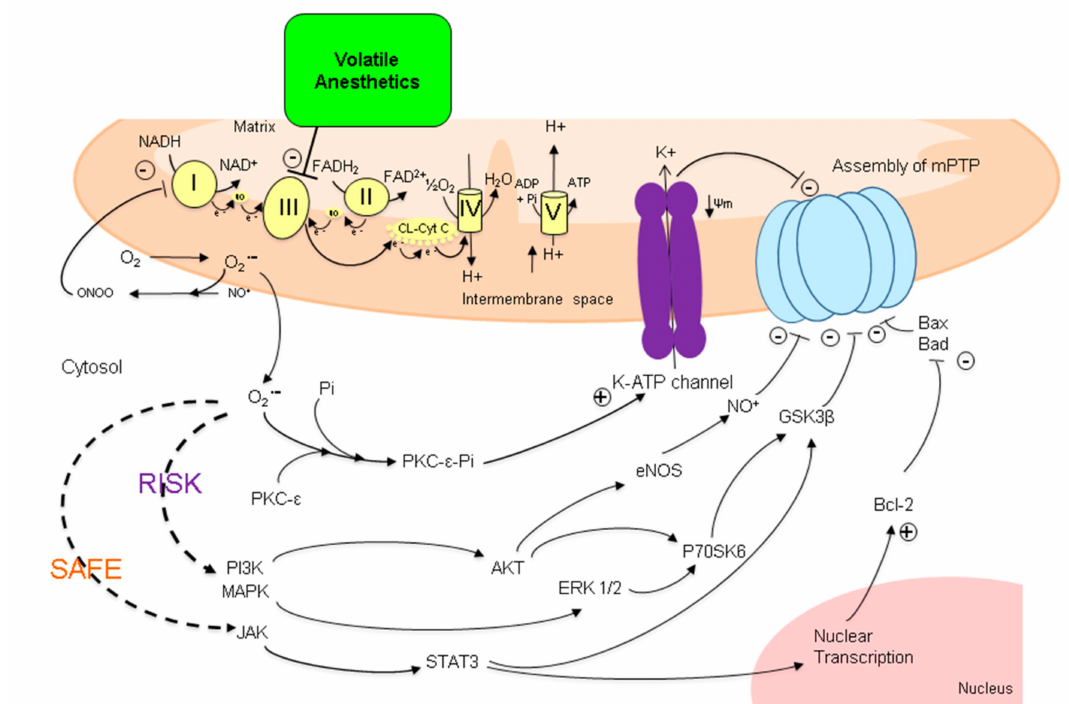
Figure 2. Proposed effects of volatile anesthetics on the level of mitochondria. VA are likely to reduce complex III activity in the mitochondrial respiratory chain, resulting in an increase in superoxide (an ROS) formation. Superoxide then may react with nitric oxide, resulting in the formation of peroxynitrite, which itself reduces electron transport at complex I leading to more superoxide formation. From here, several pathways can be induced, ultimately resulting in reduced formation of mPTP (via PKC) or the prevention of opening of mPTP (via RISK or SAFE pathways). NAD: nicotinamide–adenine– dinucleotide; FAD: flavin–adenine–dinucleotide; CL-Cyt C: cytochrome C oxidase; PKC- ε : protein kinase C- ε ; Pi: